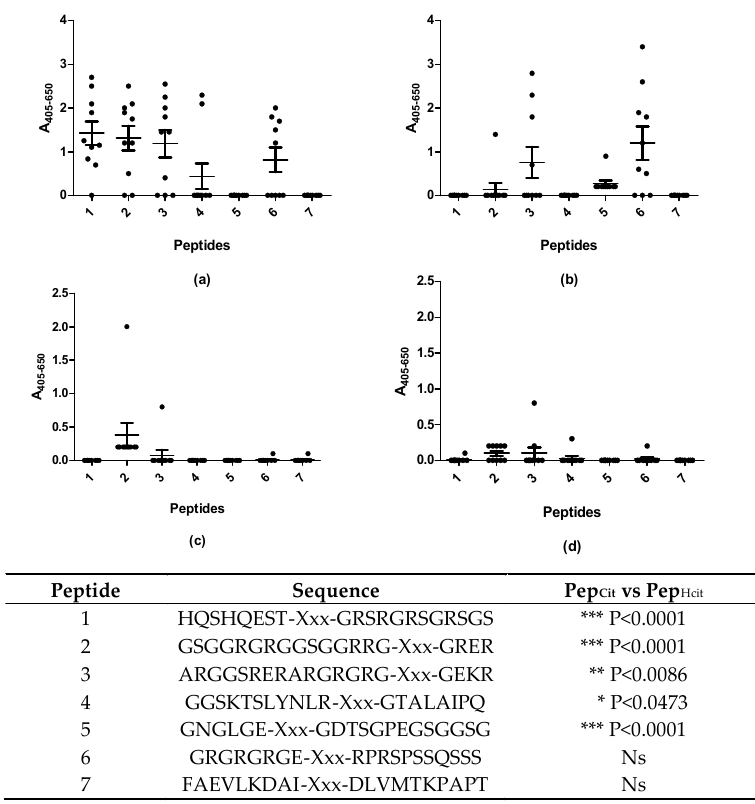
Figure 3. Reactivity of rheumatoid arthritis ( n = 10) and healthy control sera ( n = 10) to substituted peptides analyzed by streptavidin capture ELISA. ( a ) Reactivity of RA sera to citrullinated peptides; ( b ) Reactivity of RA sera to homo-citrullinated peptides; ( c ) Reactivity of HC sera to citrullinated peptides; ( d ) Reactivity of HC sera to homo-citrullinated peptides; ( e ) Peptides screened for analysis, with the statistical di ff erence in antibody reactivity between the individual citrullinated and homo-citrullinated peptides. Xxx represent the location of the substituted amino acid in the peptide. Peptide 1: pro-filaggrin (aa 306–319). Peptide 2–7: EBNA-1 derived peptides (see Table 1 for further information). All modifications replaced the positively charged amino acid arginine.